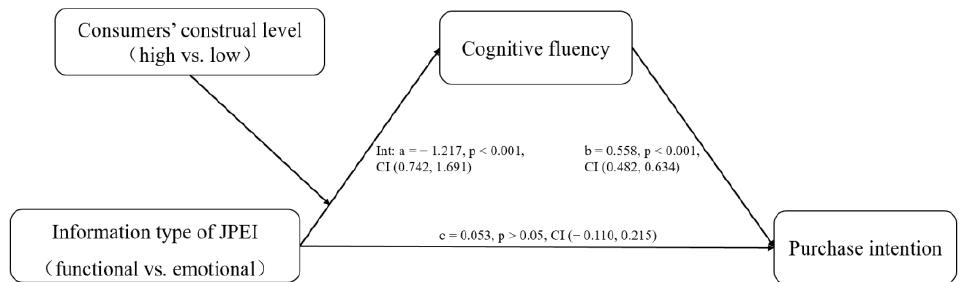
Figure 6. Results for the moderated mediation effect (Study 3).